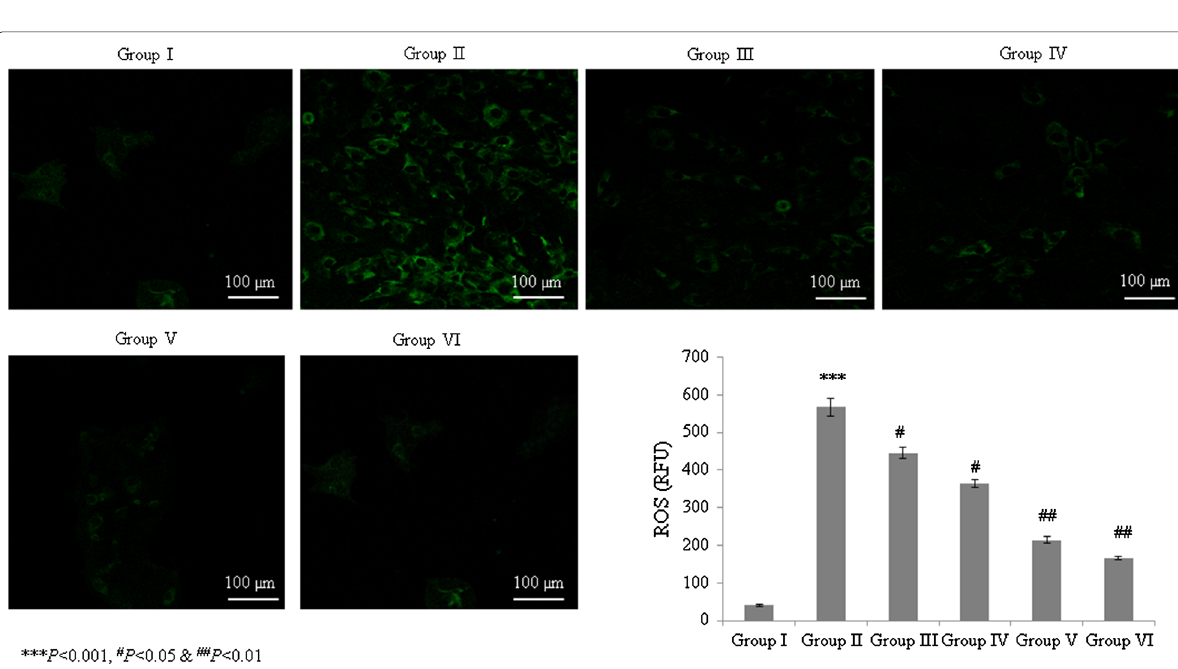
erythropoietin 1 mL/kg sesame oil combination treat- + ment markedly reduced necrosis compared with the indi- vidual 1000 U/kg erythropoietin and 1 mL/kg sesame oil treatments (Fig. 6).